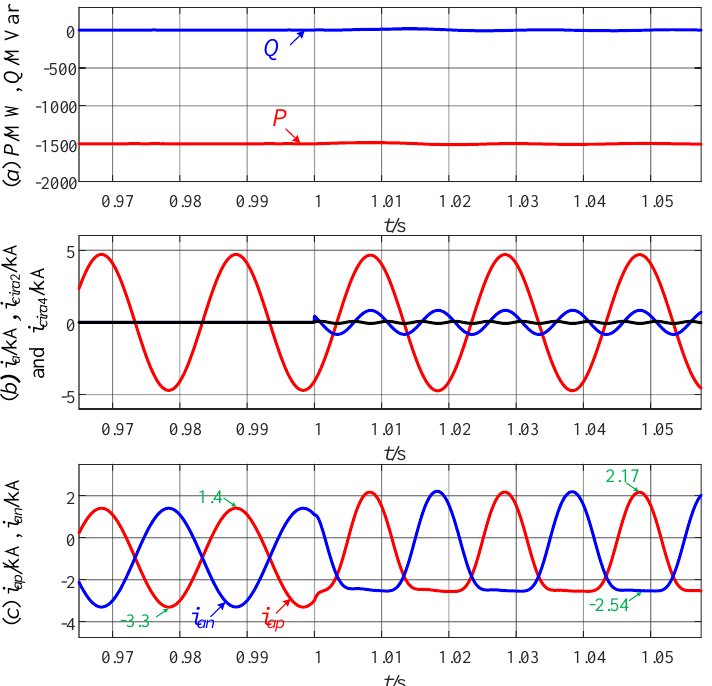
Figure 9. Simulation waveforms of the MMC operating in the rectifier mode before and after using the proposed MCCIC strategy.